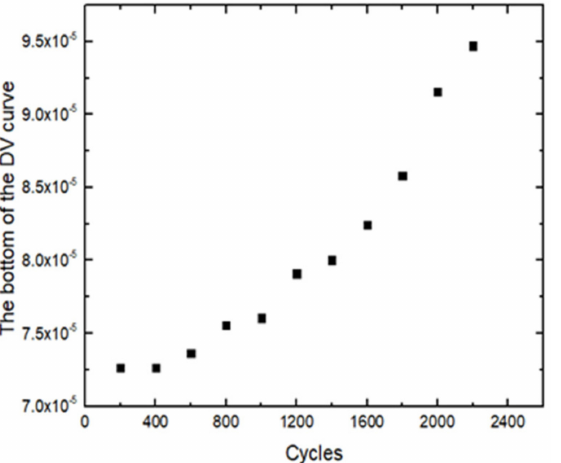
Figure 5. The bottom of the DV curve changes with changes with the number of